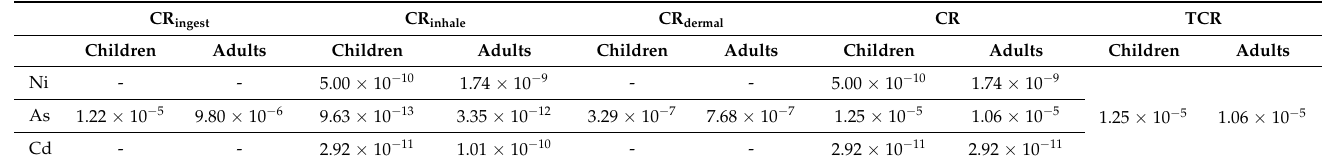
Table 5. The carcinogenic risk indexes of heavy metals in urban surface dust. CR ingest CR